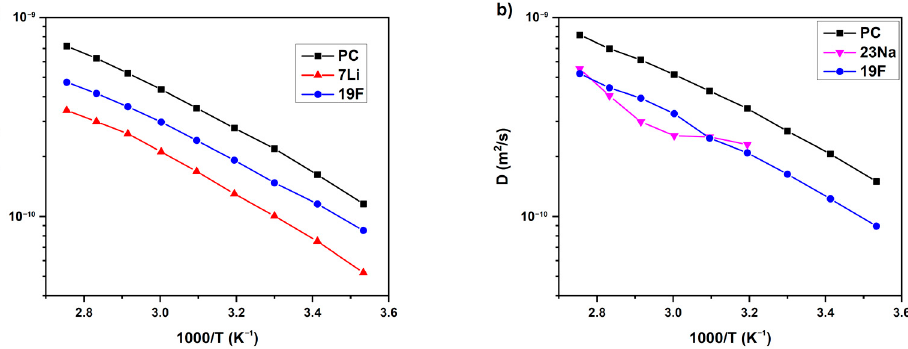
Figure 35. Temperature dependences of the NMR self-diffusion coefficients for the LiTFSI-0%G ( a ) and NaTFSI-0%G ( b ) electrolytes (without PAMAM). Solid lines are guides for the eye [136]. The effect of PAMAM on the diffusivity of Li + cation (a), TFSI - anion (b), PC molecules (c), and PAMAM molecules (d) in LiTFSI containing electrolytes is demonstrated in Figure 36.